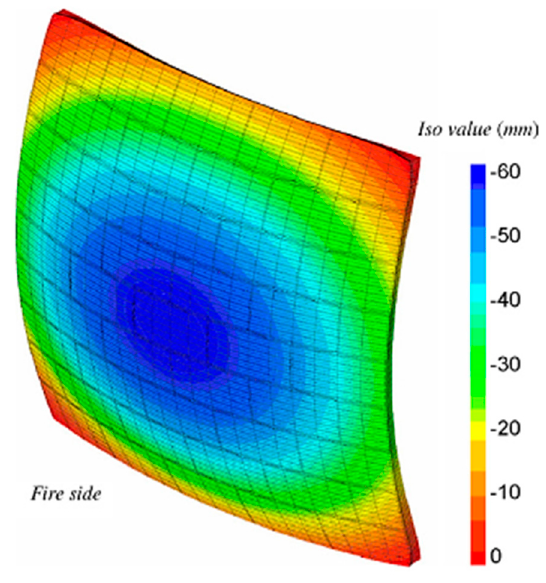
Figure 1. Displacement of the wall nearing the heat source [21].